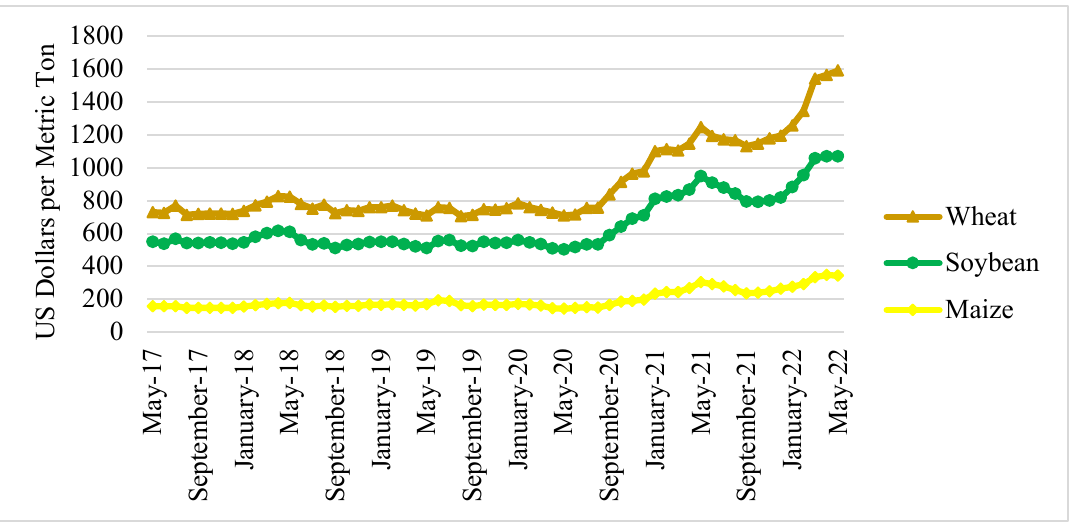
Figure 5. Global food prices from May 2017 to May 2022. Source: [28]. Global food prices increased drastically in 2022, especially in March, one month after the Russian attack on Ukraine. World soybean prices rose by 8.91% in March and rose again by around 0.03% and 0.46% in April and May, respectively. The price of maize increased higher than that of soybean, rising by 14.66% in March 2022, 3.77% in April 2022, and 0.95% in May 2022. Wheat saw the greatest price increase among all food products. This commodity’s price rose to 24.53% in March and then increased again in April (1.85%) and May (5.45%). According to the FAO [29], the global food and feed prices will increase by 8% to 22% beyond their current high baseline levels if this conflict is not resolved early. The prices of wheat, soybeans, and maize were then compared across time (Table 2). During the Russian–Ukrainian crisis, the average (mean) price of the three commodities has been at its highest. Compared to normal conditions, the average price has doubled. Meanwhile, the COVID-19 period had the most price fluctuations (standard deviation). However, given that the battle between Russia and Ukraine has been going on for a short